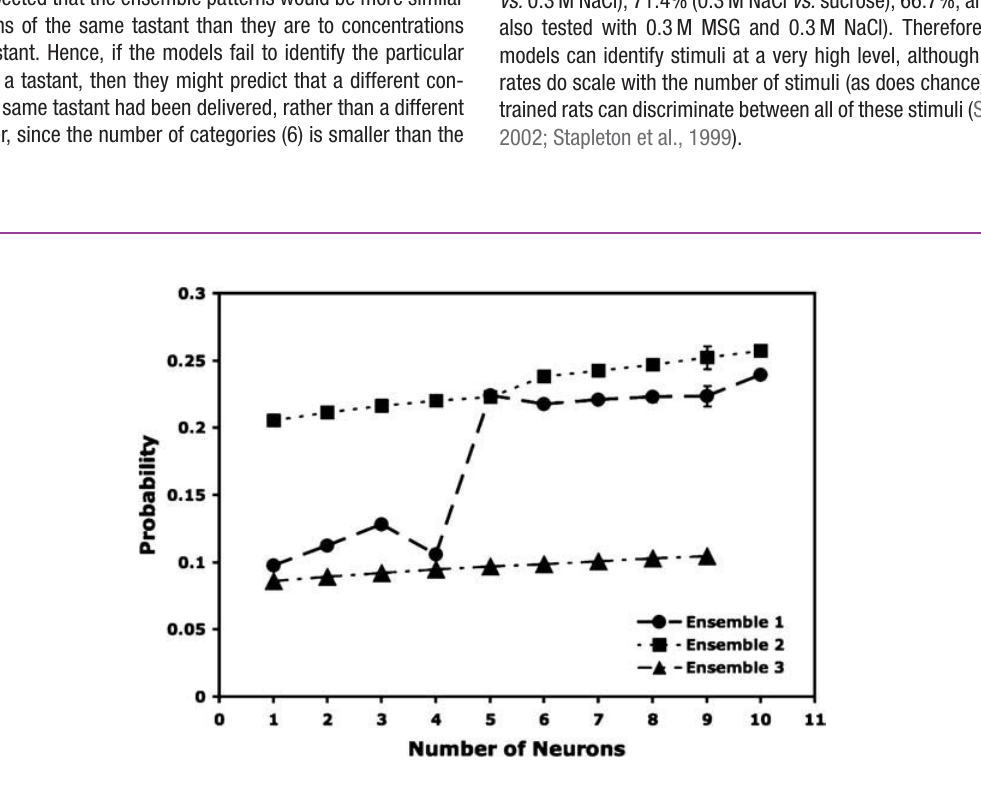
Figure4. Predictionprobabilityasafunctionofthenumberofneuronsinanensemble. Displayedabovearethemeans ± SEMsofthepredictionprobabilities for three representative ensembles. The number of neurons dropped from each ensemble is displayed on the abscissa, and the corresponding probability is displayed on the ordinate. It should be noted that the SEMs are very small and thus are not visible at most points. The first two ensembles contained 10 neurons, and the third ensemble contained 9 neurons. In the case of ensembles 1 and 3, dropping increasing numbers of neurons causes a monotonic decrease in the prediction probability. Predictions for ensemble 2 remained high until six or more neurons had been removed from the ensemble, after which the probabilities decreased